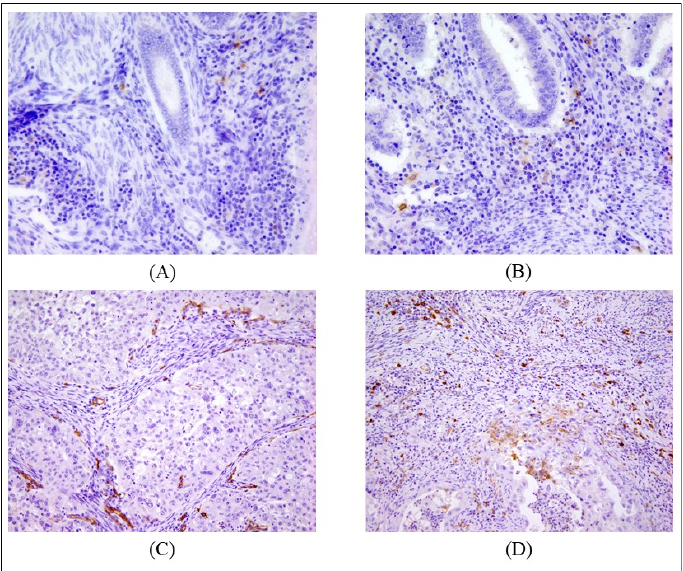
Figure 1. Examples of positively identified DCs infiltrating EC samples. A cell was considered as positively stained if at ×40 magnification it had a visible nucleus, dendritic appearance, and intensely colored cytoplasm. ( A ) DC CD83+ infiltrating stroma of endometroid cancer at 40× magnification (8 cells/high-power field (HPF)); ( B ) DC CD83+ infiltrating border of endometroid cancer at 40× magnification (12 cells/HPF) ( C ) DC CD123+ infiltrating stroma of endometroid cancer at 40× magnification (52 cells/HPF); ( D ) DC CD123+ infiltrating invasive border of endometroid cancer at 20× magnification. In ( C , D ) a sign of staining can be seen in the endothelium of intratumoral vessels.